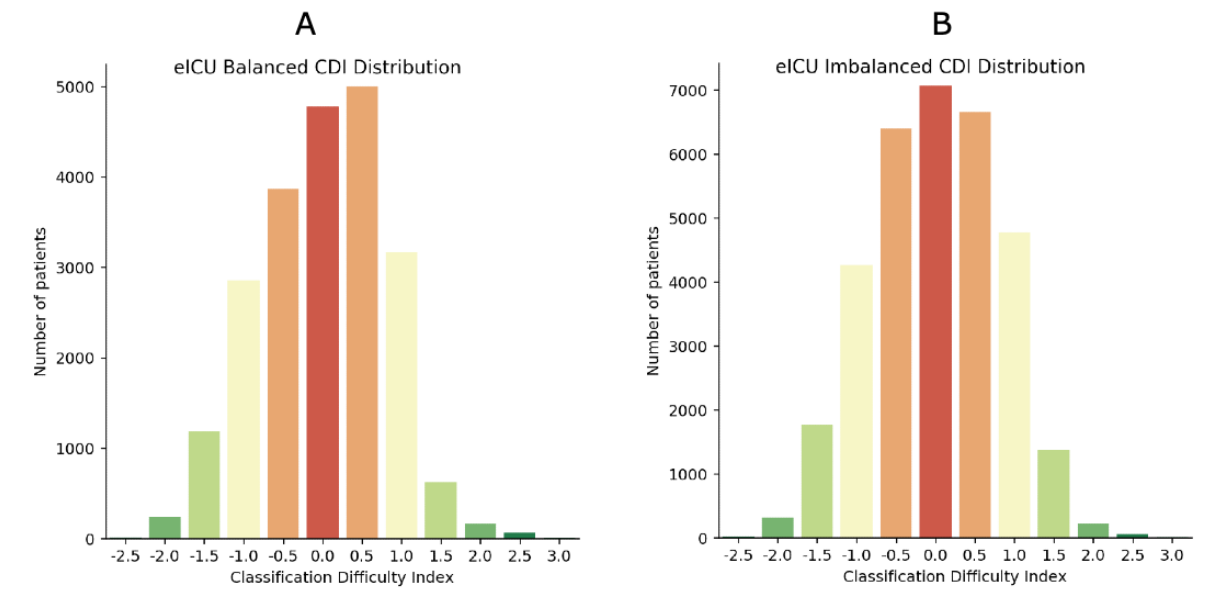
Figure 3. Classification Difficulty Indexes in eICU (A) balanced and (B) imbalanced data. eICU: electronic Intensive Care Unit; DT: decision tree; KNN: K-nearest neighbors; LDA: linear discriminant analysis; LR: logistic regression; NB: naive Bayes; NN: neural